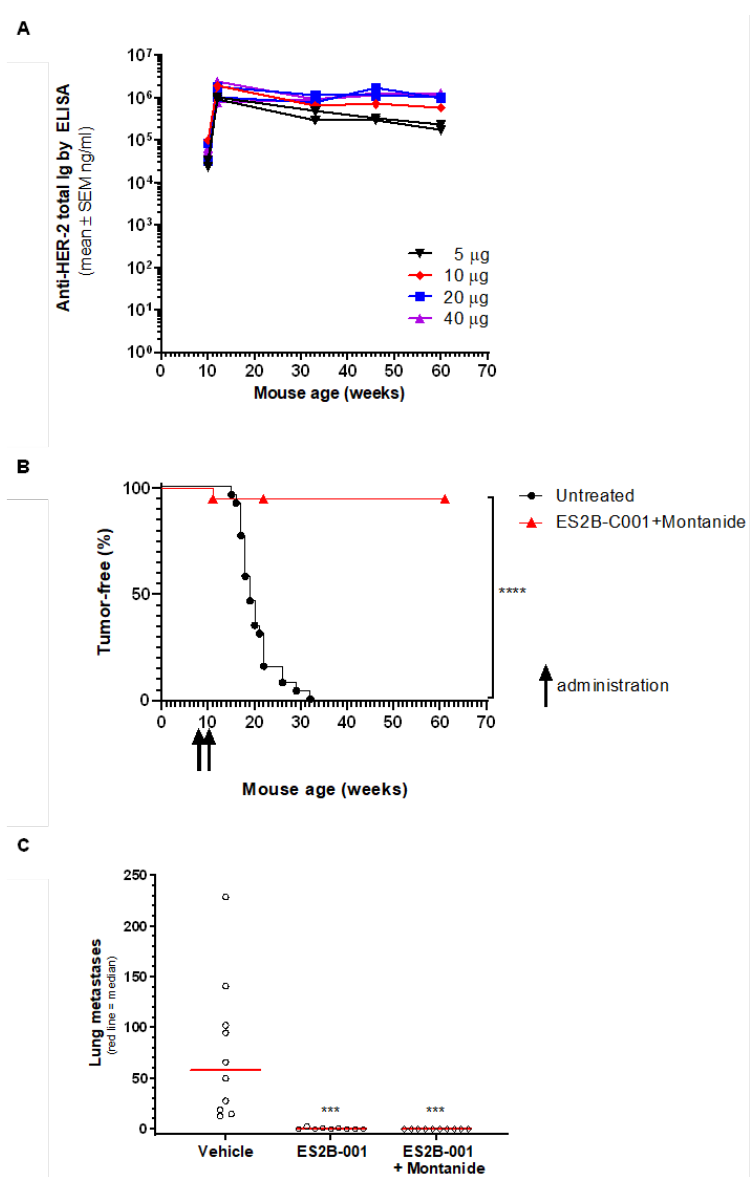
Figure 7. Prophylactic ES2B-C001 vaccination prevented mammary carcinoma onset in HER-2 transgenic Delta16 mice and therapeutic vaccinations inhibited lung metastases outgrowth. ( A , B ) A group of 20 mice vaccinated with ES2B-C001+Montanide (5 – 40 µg/mouse) was followed for more than one year for spontaneous tumor onset and antibody titers. ( A ) Long-term anti-HER-2 antibody response elicited in Delta 16 mice by ES2B-C001 vaccinations, as measured by ELISA; each line represents one mouse. ( B ) The Kaplan–Meier tumor-free survival curve of pooled Delta16 mice vaccinated twice with ES2B-C001 was significantly different (**** p < 0.0001 by the log-rank test) from untreated Delta16 mice. ( C ) Therapeutic vaccination of young, tumor-free Delta16 mice challenged i.v. with 0.25 × 10 6 QD cells; each point represents the total number of lung nodules of one mouse, as counted under a dissection microscope; *** p < 0.001 vs. vehicle by the Dunn’s non-parametric